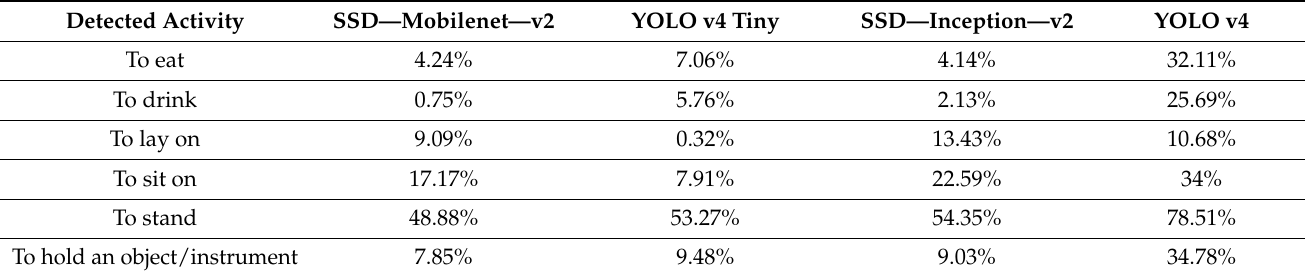
Figure 4. ( a ) Input frame; ( b ) HOI detections using YOLO V4 tiny; ( c ) HOI detections using SSD- MobleNet V2; ( d ) HOI detections using YOLO V4. Table 5. HOI detection evaluation for the most relevant